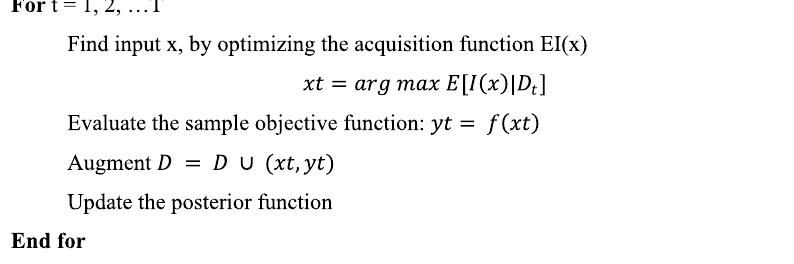
Fig. 3 Framework of Bayesian